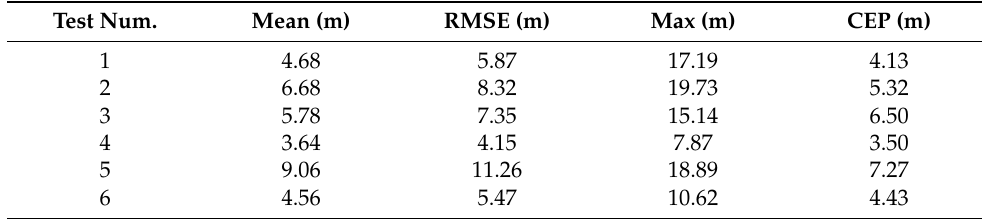
Table 1. Analysis of ESDTW positioning